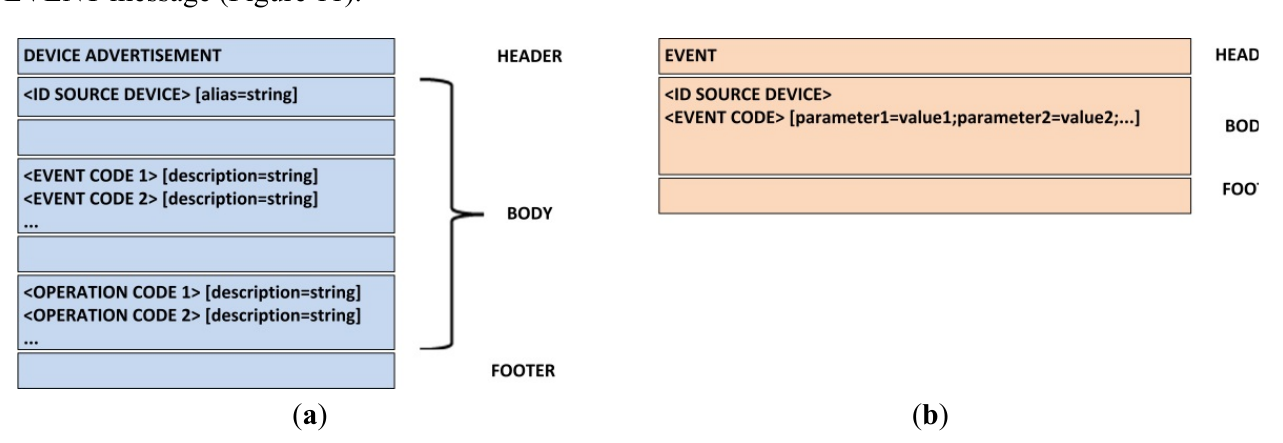
Figure 11. Scheme of protocol messages; ( a ) DEVICE ADVERTISEMENT message; ( b ) EVENT